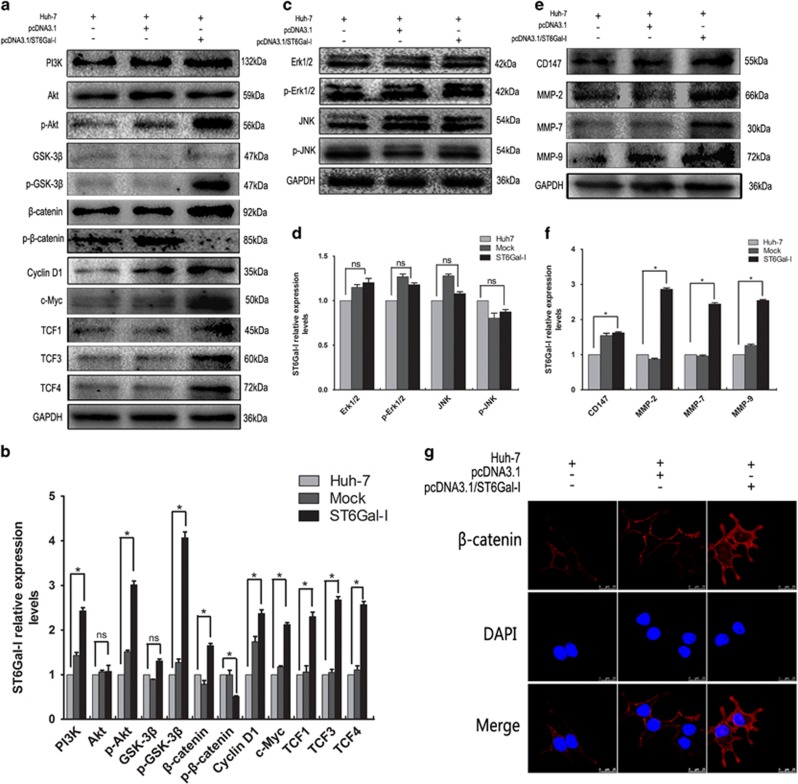
Upregulation of ST6Gal-I activates PI3K/Akt, and Wnt/β-catenin signaling pathways in Huh-7 cells. (a, c, e) Main protein components of the PI3K/Akt/MAPK/β-catenin signaling pathway in Huh-7 cells were measured using western blotting. (b, d, f) Relative protein intensities were determined with the Image Lab software (Bio-Rad). *P<0.05. (g) Immunofluorescence imaging analysis was used to monitor β-catenin release from the cytosol into the nuclear space upon overexpression of ST6Gal-I; representative figures are shown. The error bars represent the s.d. of the mean values obtained from triplicate experiments. *P<0.05.